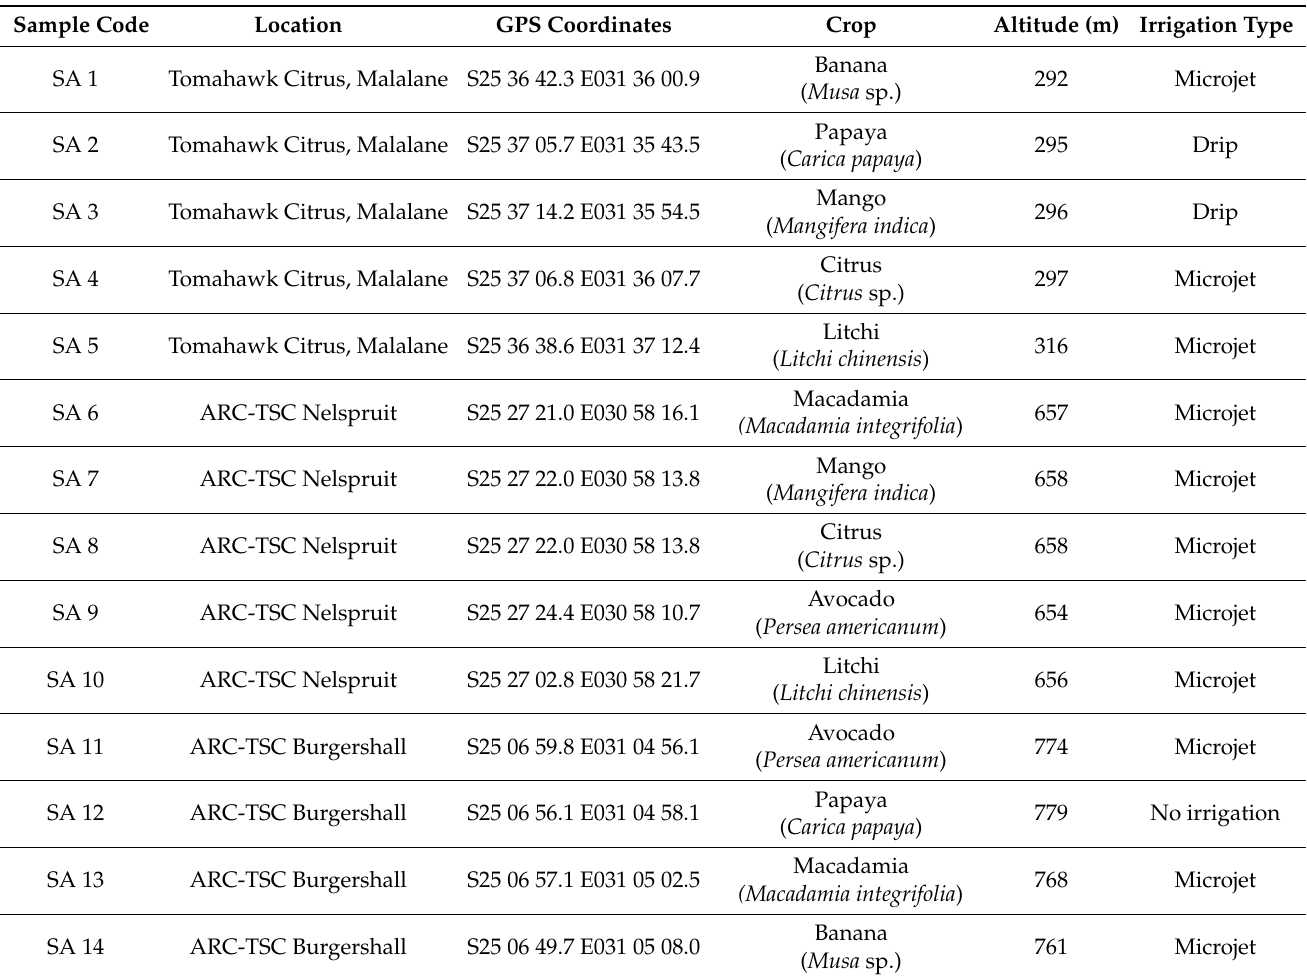
Table 1. Information regarding sampling localities and tree crops from which the soil microbial communities were extracted from rhizosphere samples to allow evaluation of their nematicidal potential against the root-knot nematode species Meloidogyne enterolobii